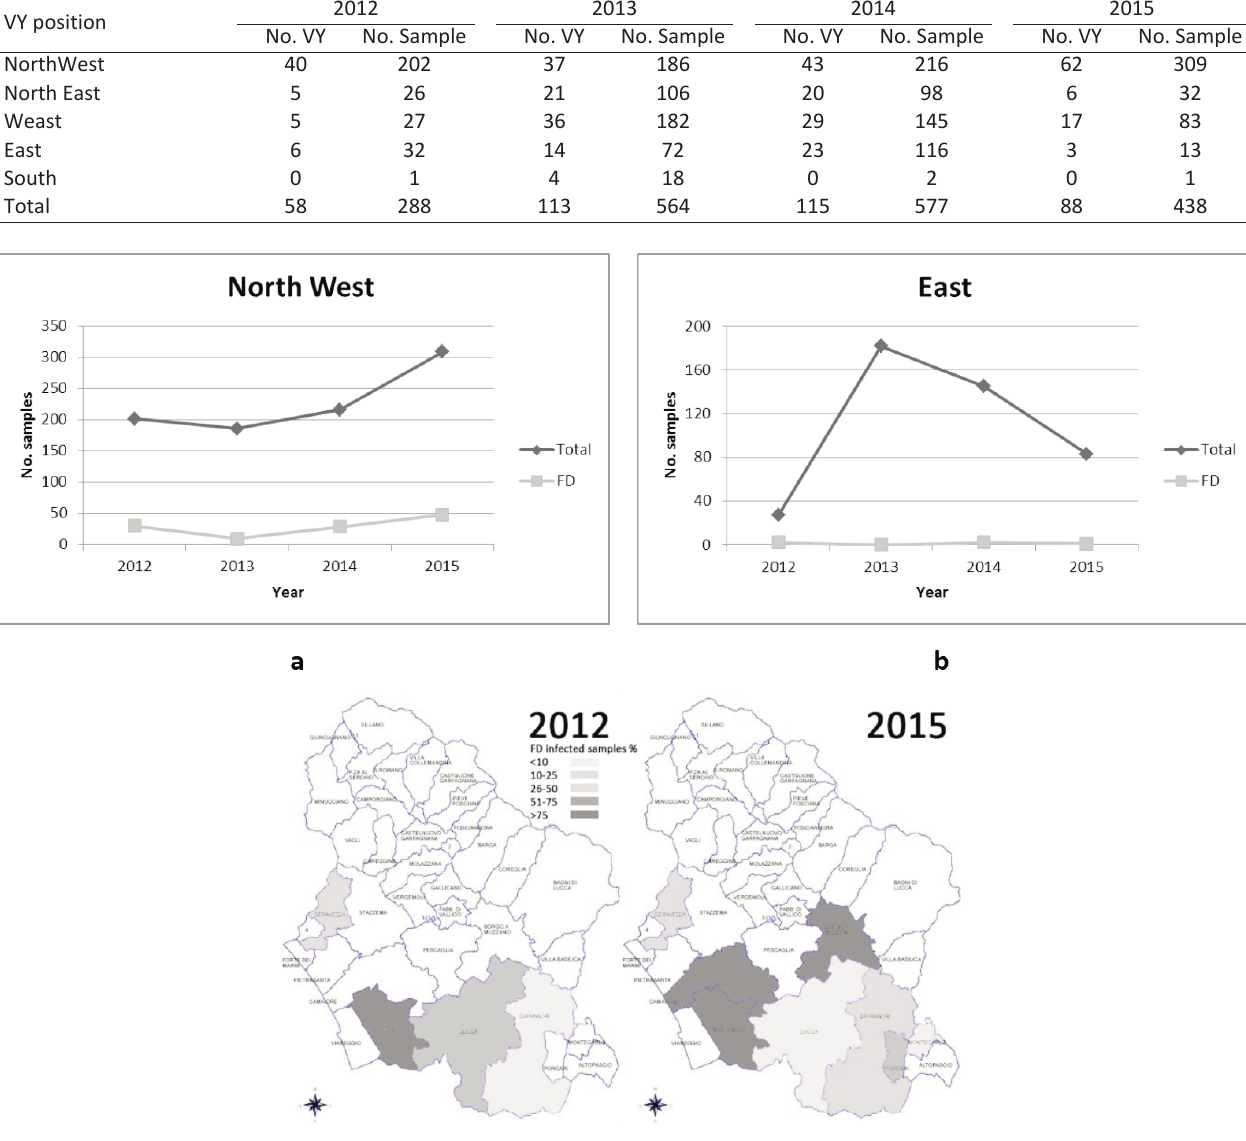
Table 1 - Tuscan vineyards (VY) and samples included in grapevine yellows monitoring